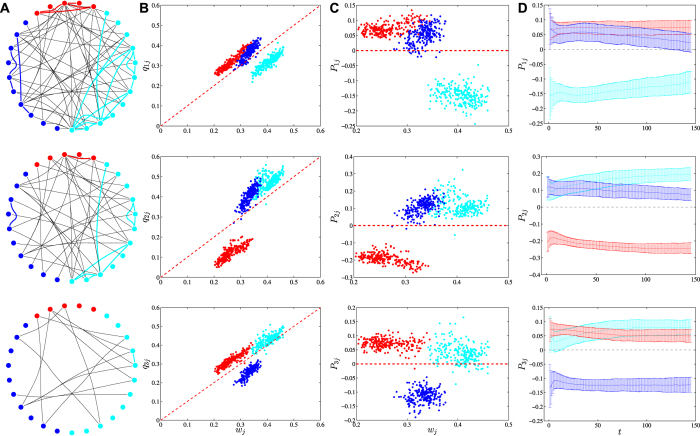
Empirical evidence of heterophily in the socioeconomic networks of virtual societies on a typical day t = 15.Warriors, priests and mages are marked respectively in cyan, red and blue. (A) Networks of 27 agents randomly chosen from a virtual society filtered by three intimacy thresholds Ic = 0, 100 and 2000 (top to bottom). (B) Dependence of qs,ij on relative size ws,j for all virtual societies for Ic = 100. In each plot, there are three well isolated clusters. For most societies, qs,ij > ws,j when i ≠ j and qs,ij < ws,j when i = j. (C) Dependence of preference measure Ps,ij on relative size ws,j for all societies for Ic = 100. There are also three well separated clusters in each plot. For most societies, Ps,ij > 0 when i ≠ j and Ps,ij < 0 when i = j. (D) Evolution of the averaged preference measure Ps,ij over all virtual societies for Ic = 100. The preference measures are roughly persistent.